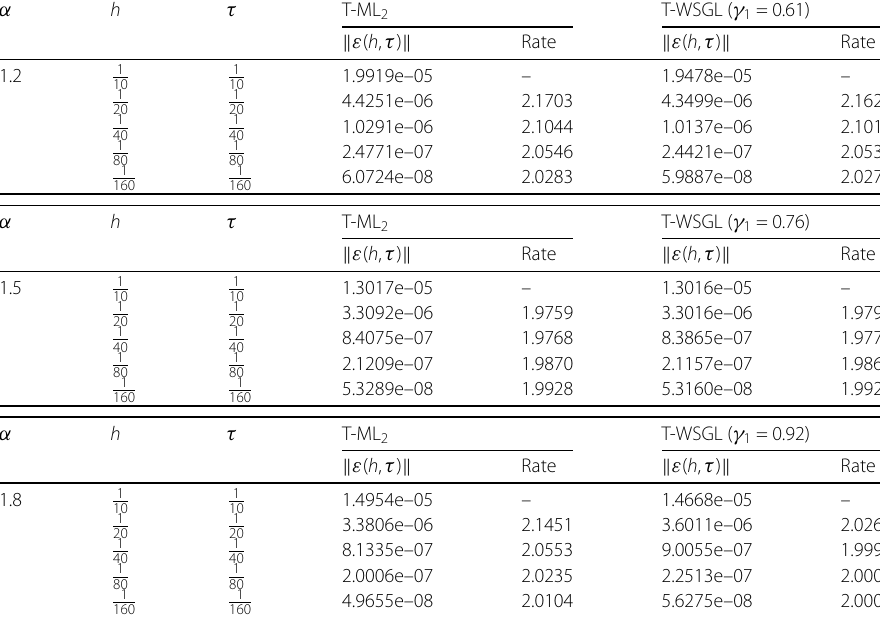
Table 2 Errors and corresponding observation orders with λ = 1, and the parameters γ 1 , γ 2 , γ 3 are ( γ 1 , γ 2 , γ 3 selected in S α 1